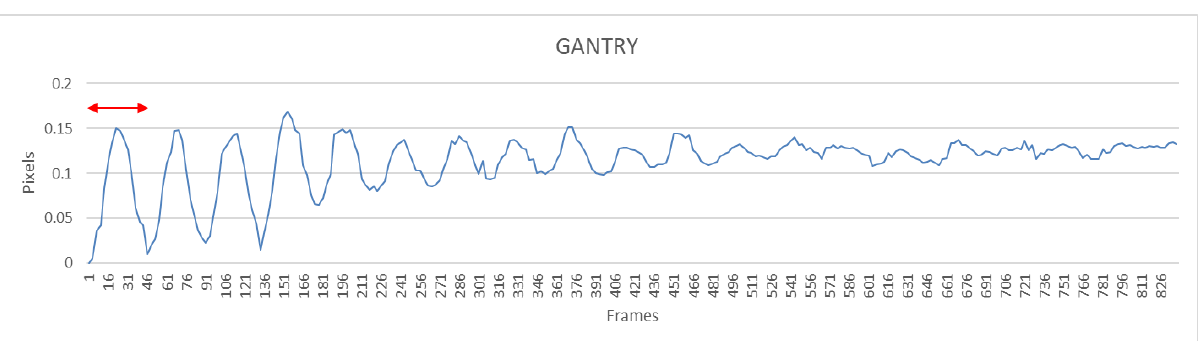
Figure 11 – DIC analysis’ results on the gantry’s Scanner